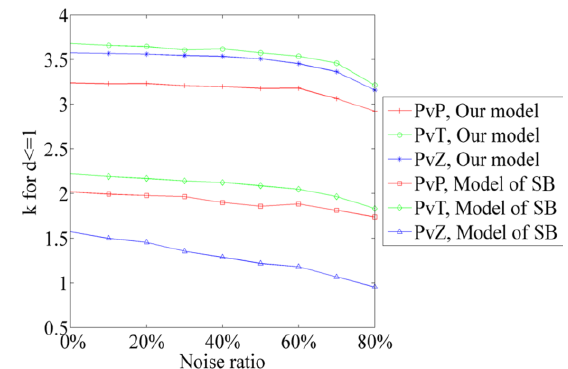
Figure 6. Number of buildings that our model and the model of Synnaeve and Bessiere (SB) [21] can predict in advance at a maximum distance of 1 ( for ) for different match-ups.